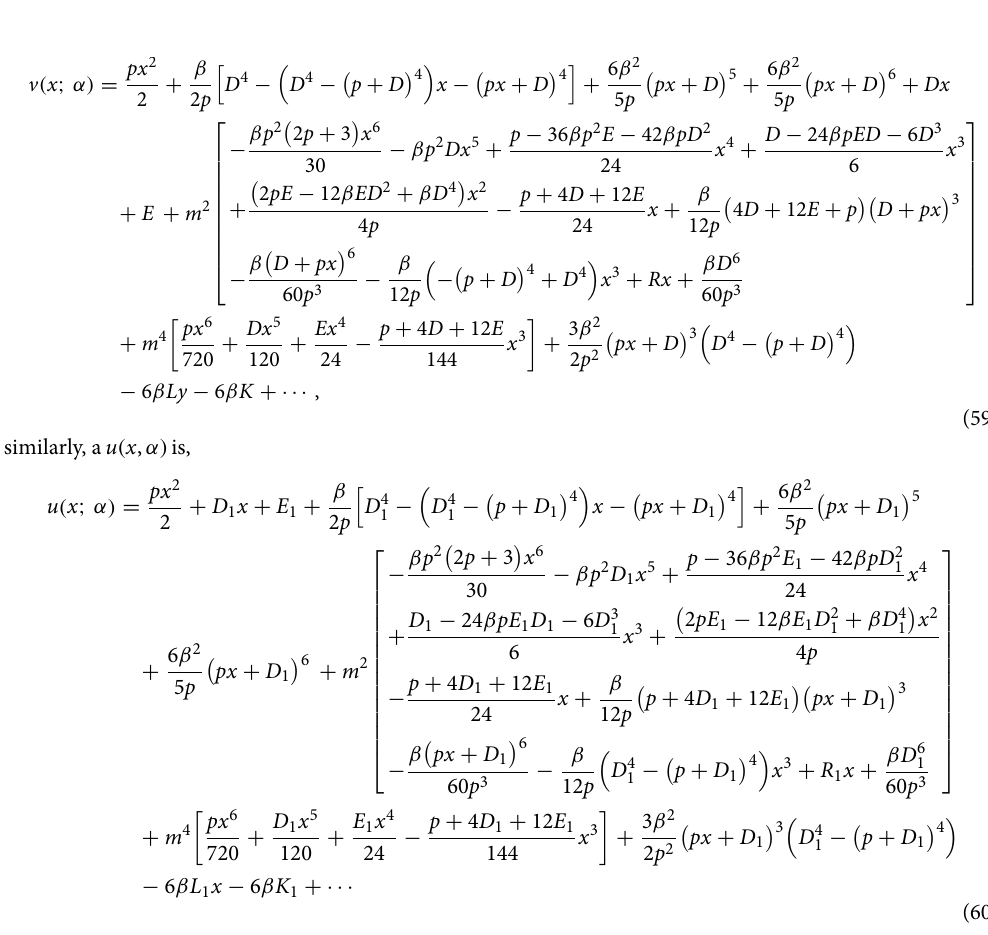
Figure 3. Fuzzy velocity profiles for the impact of